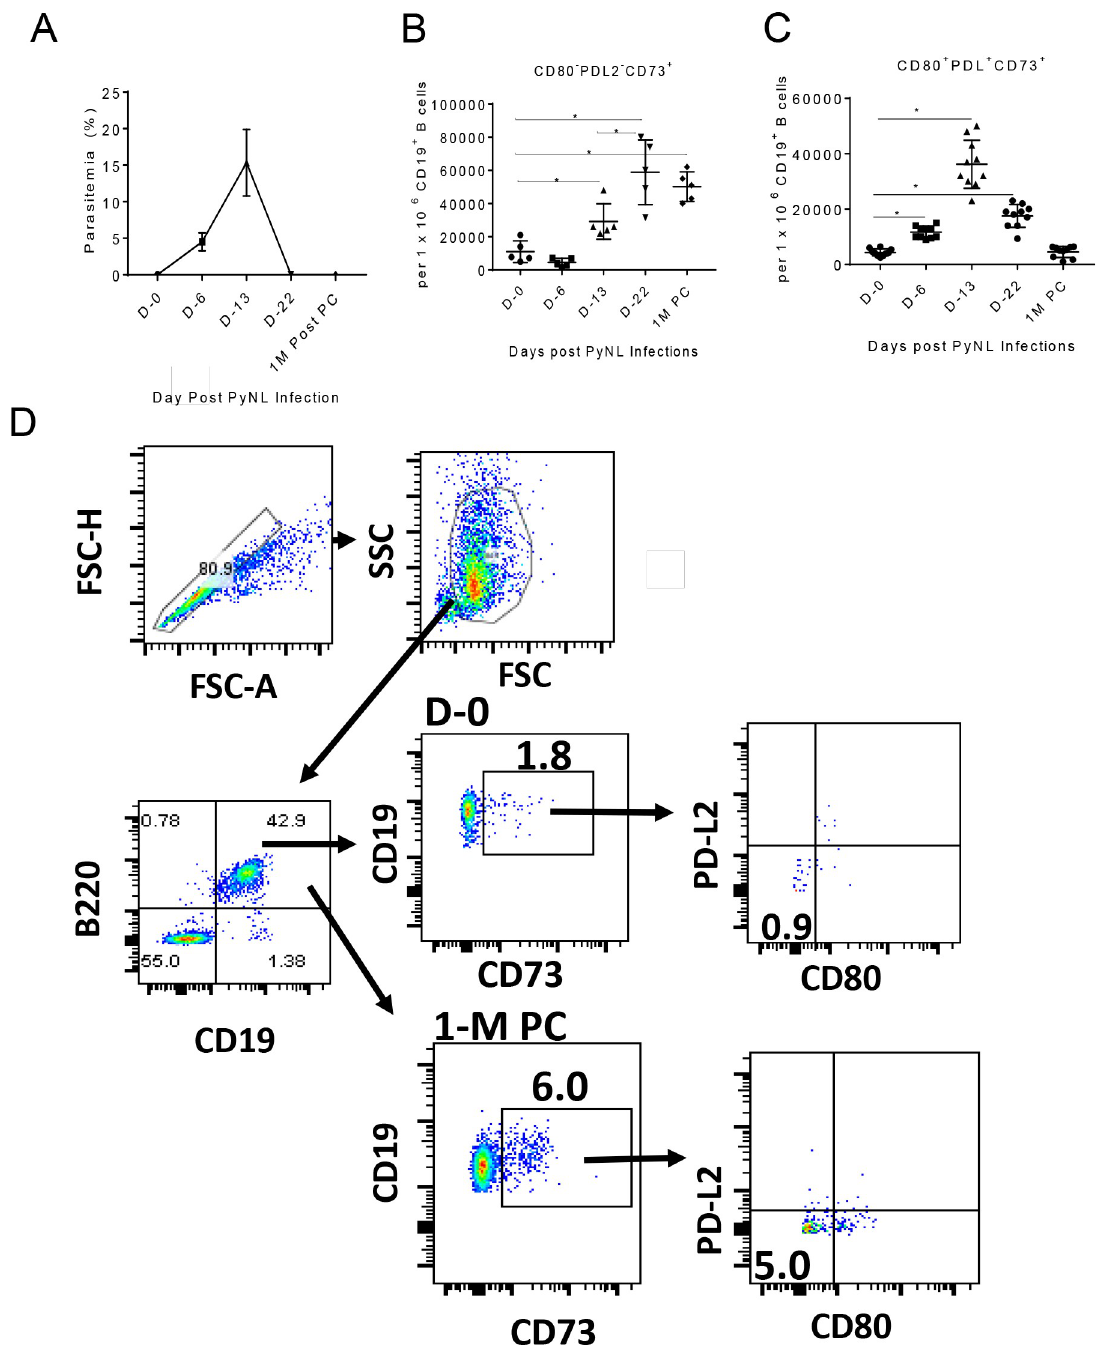
Fig 2. Kinetics of the expansion of CD19 + B cells expressing CD80, PD-L2 and CD73 markers post-primary PyNL infection. (A) Percent parasitemia over the course of a PyNL infection measured by blood smear evaluation. Expansion of splenic (B) CD80 - PD-L2 - CD73 + and (C) CD80 + PD-L2 + CD73 + B cell populations (mean ± SEM) measured by flow cytometry over the course of a PyNL infection and at 1 month post-parasitemia clearance (1-M PC). (D) Representative dot plots show gating strategy and frequencies of splenic CD80 - PD-L2 - CD73 + B cells from mice at D-0 and at 1-M PC. Mann-Whitney test was used for statistical evaluation; � p < 0.05; n = 5 mice per group. Results are expressed as per 1 x 10 6 CD19 + B cells from one experiment out of two with similar results. � p < 0.05; n = 5 mice per group.